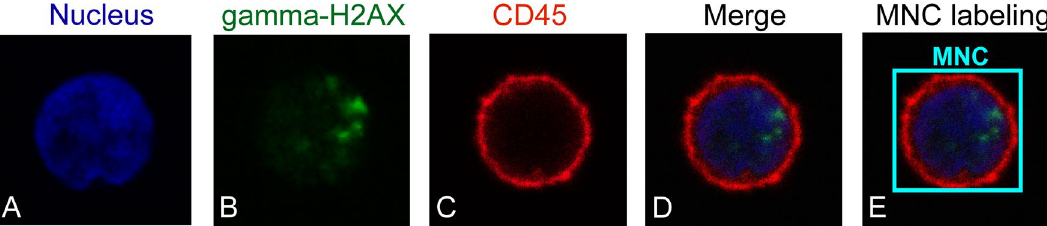
Figure 2. Preprocessing and data labeling used in the first-stage model. Confocal microscopic images of white blood cells. The images showed nucleus in blue ( A ), γ-H2AX foci in green ( B ), and the CD45 surface marker in red ( C ). Those three channels were merged prior to use as a dataset of the cell detection model ( D ). The mononuclear cell (MNC) was manually labelled using a rectangular bounding box ( E ).